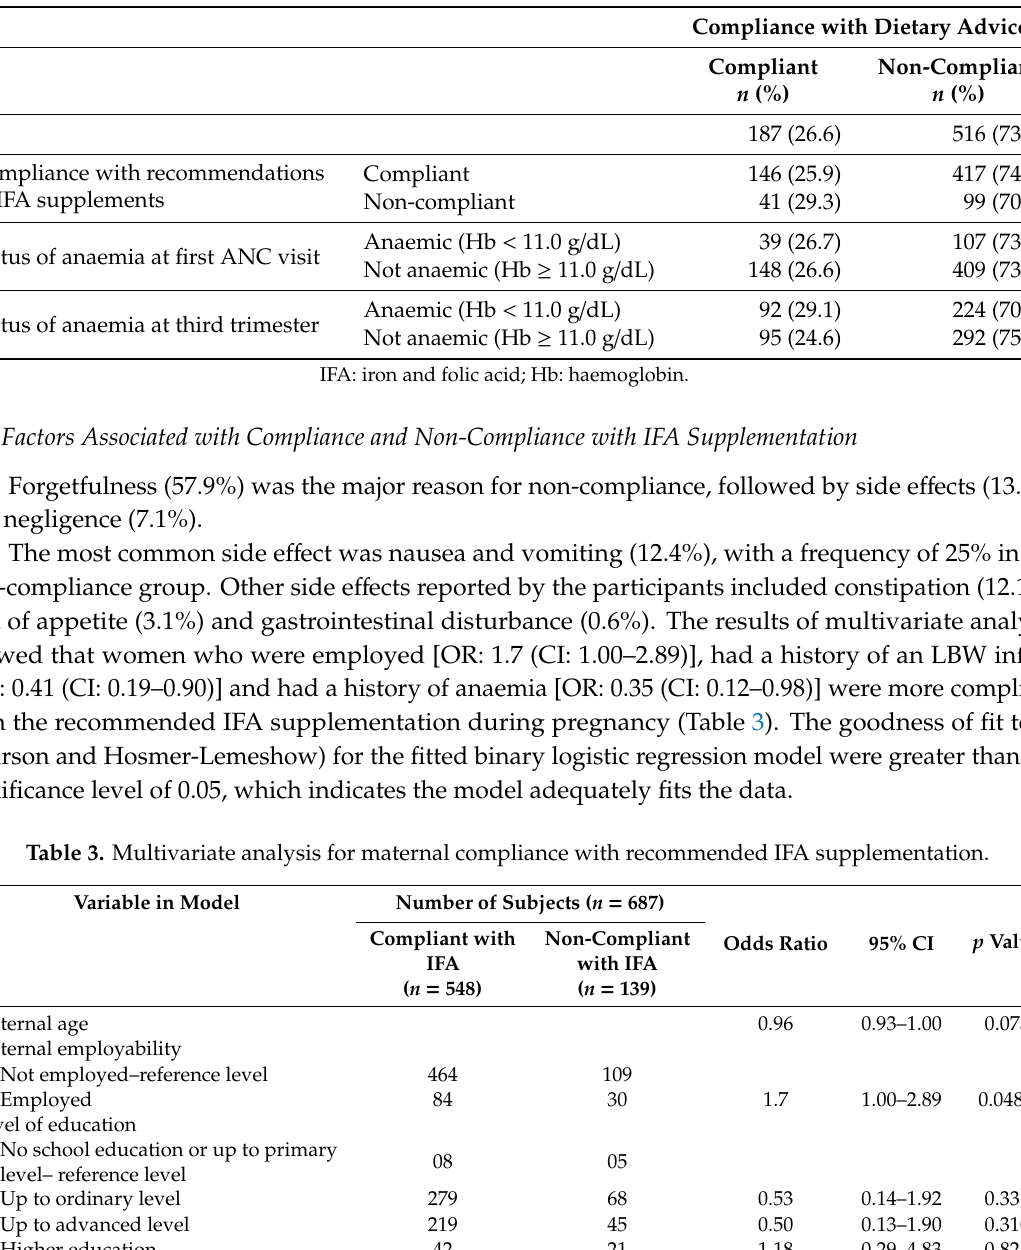
Table 2. Maternal compliance with dietary advices vs. compliance with IFA supplements and anaemic status.